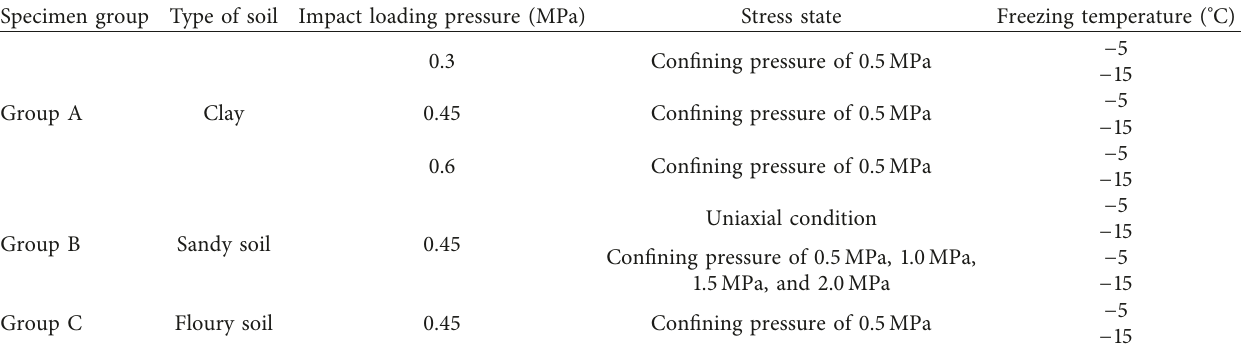
Table 3: SHPB test design for three types of frozen soil.